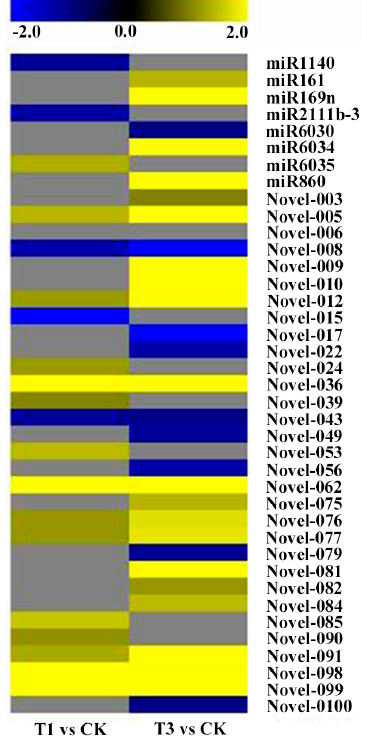
Figure 6. Differential expression of conserved miRNAs and novel miRNAs between two samples.